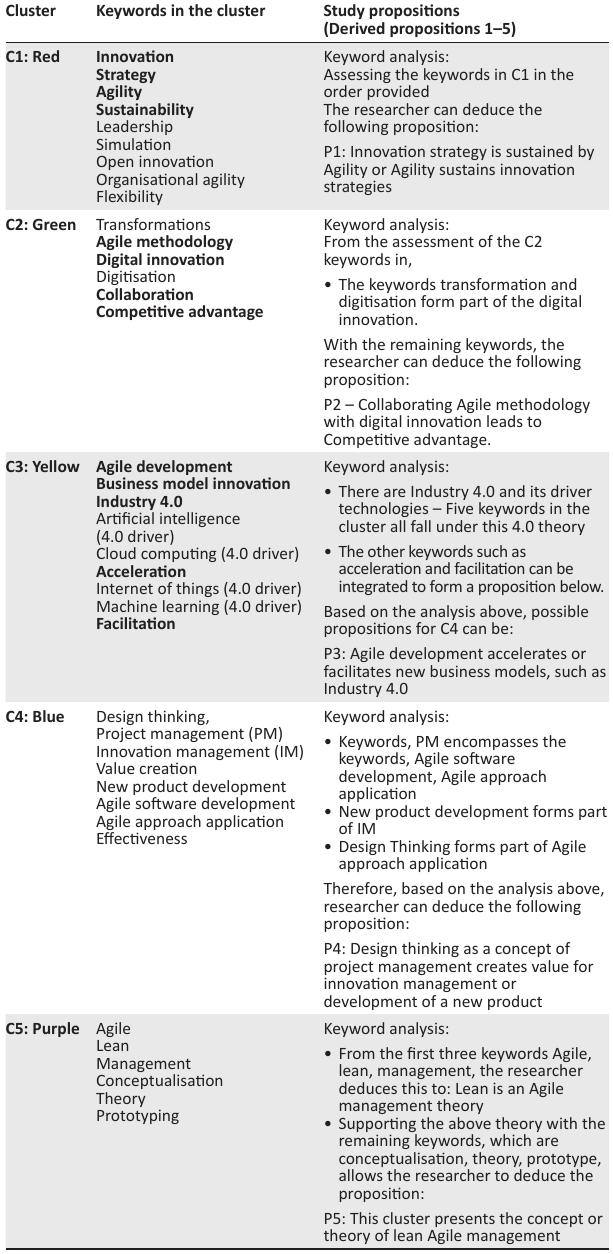
Keyword Link strength (highest to